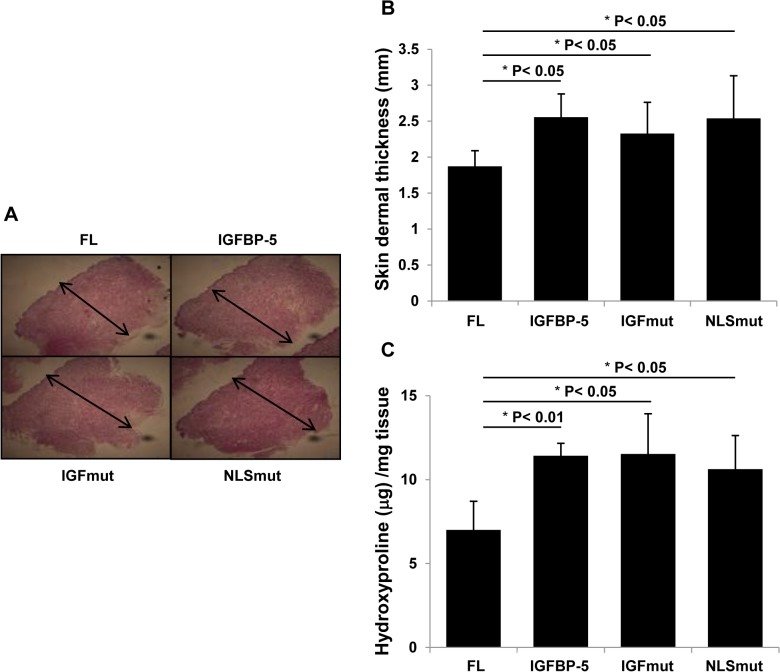
Mutant IGFBP-5 is pro-fibrotic ex vivo in human skin.Human skin from four different donors was injected with the indicated IGFBP-5 expressing adenoviruses and maintained in organ culture for 10 days. (A) Skin was harvested and examined histologically. (B) Dermal thickness was measured in human skin explants. (C) ECM was quantified using hydroxyproline assay. Data in (B) and (C) represent mean and standard deviation.